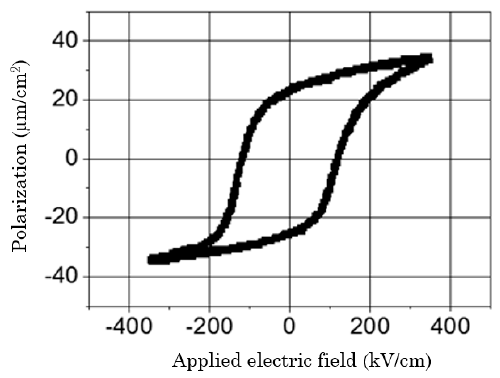
Figure 4. Hysteresis loop (P(E)) of a 4 µm PZT film deposited onto a 30 µm aluminium foil.